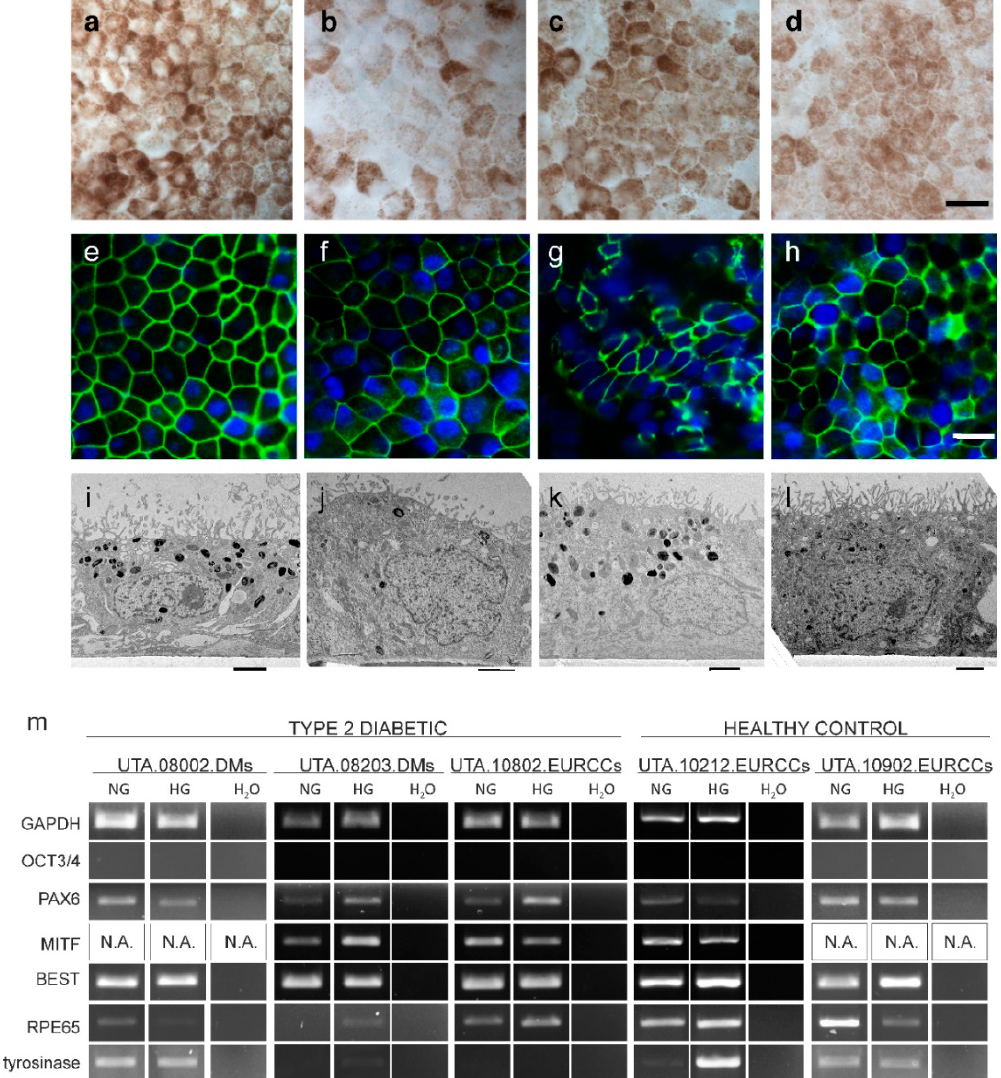
Figure 3. Characterization of RPE specific features. ( a – d ) The phase contrast micrographs taken after the five weeks of cultivation showed a substantial amount of pigmentation in type 2 diabetic and healthy control cell lines ( a ) type 2 diabetic, UTA.08002.DMs; ( b ) type 2 diabetic, UTA.08203.DMs; ( c ) type 2 diabetic, UTA.10802.EURCCS; and ( d ) healthy control, UTA.10902.EURCCs. The scale bar represents 20 µ m. ( e – h ) Immunofluorescent staining of tight junction ZO-1 localized to the cell edges. ( e ) type 2 diabetic, UTA.08002.DMs; ( f ) type 2 diabetic, UTA.08203.DMs; ( g ) type 2 diabetic, UTA.10802.EURCCS; and (h) healthy control, UTA.10902.EURCCs. The scale bar